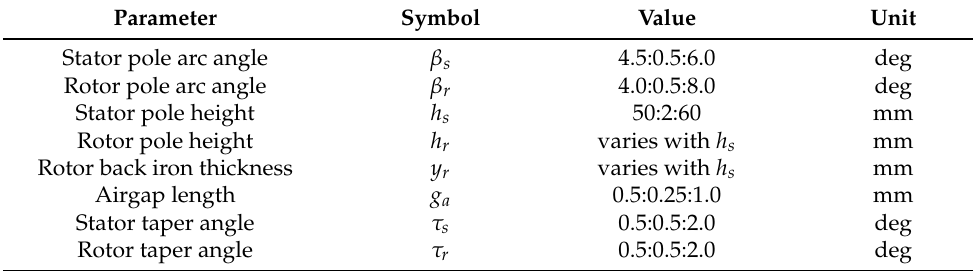
Table 6. 36/24 SRM; geometry